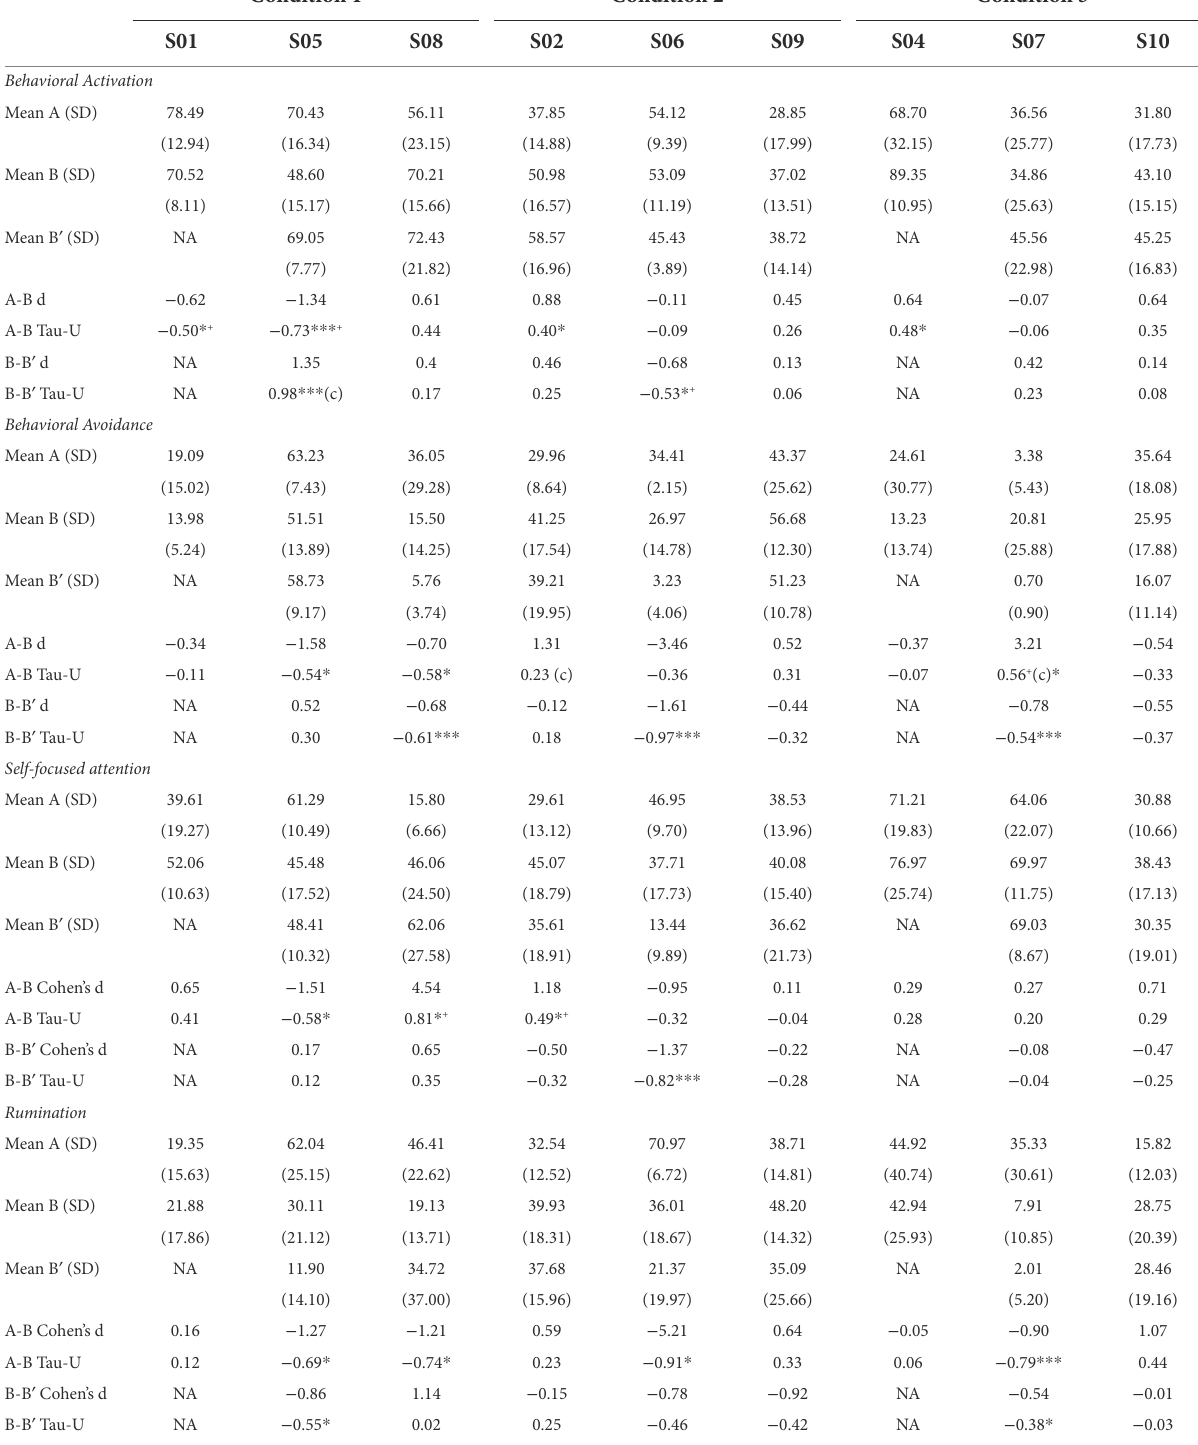
TABLE 5 Means, standard deviations, Tau-U and Cohen’s d scores for intervention’s-specific measures for all participants across